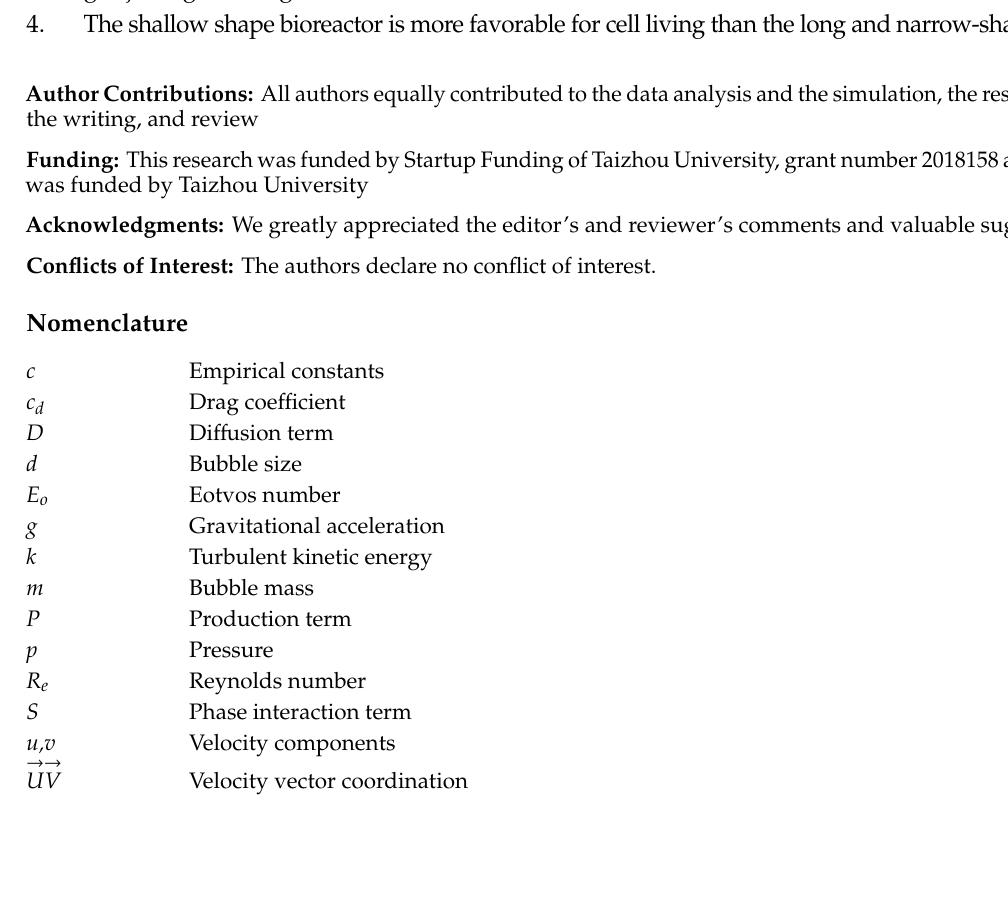
Figure 10. Comparisons of two-phase turbulent energy production